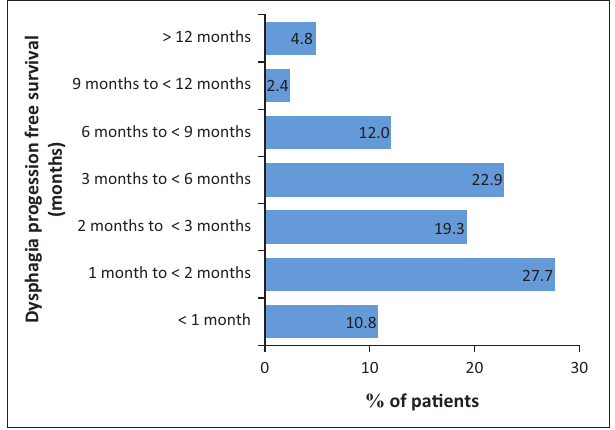
FIGURE 2: Duration of dysphagia progression free survival.